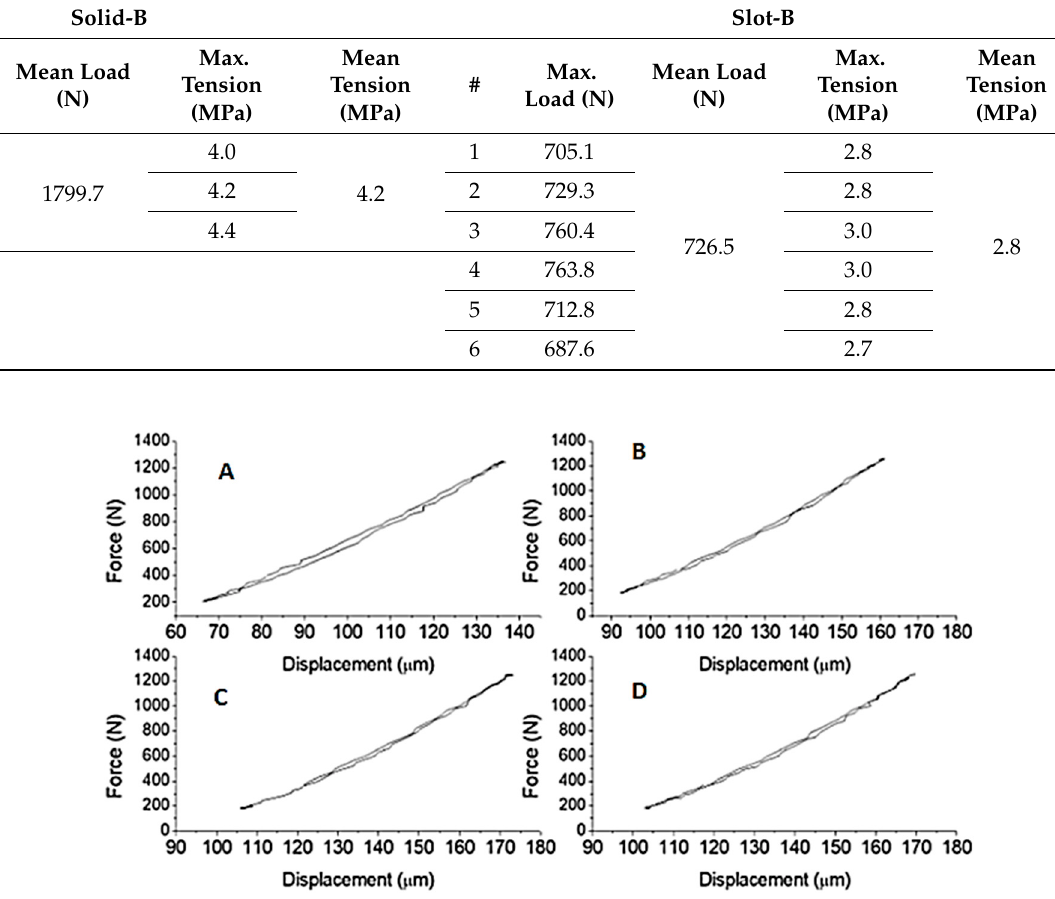
Table 2. Experimental results of the bending tensile strength test.